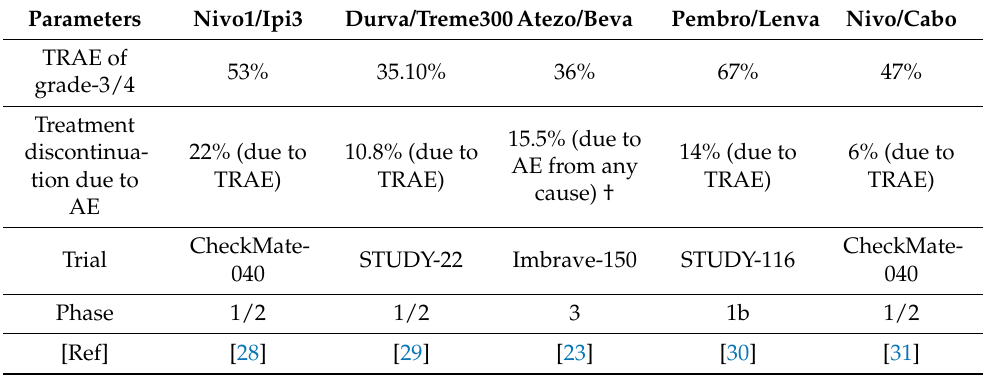
Table 3. Safety profiles in the immuno-oncology-based combination